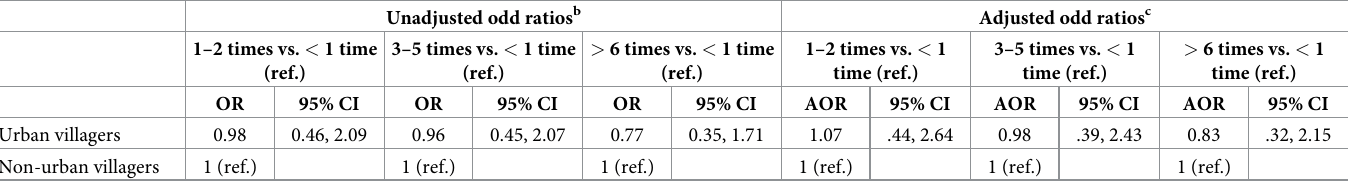
Table 3. Odd ratios of frequency of engaging in recreational physical activity per week between urban villagers and non-urban villagers. Unadjusted odd ratios b Adjusted odd ratios c